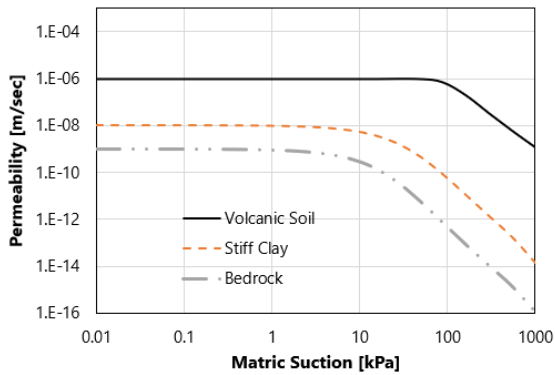
Figure 11. Permeability function based on Fredlund, Xing [31].